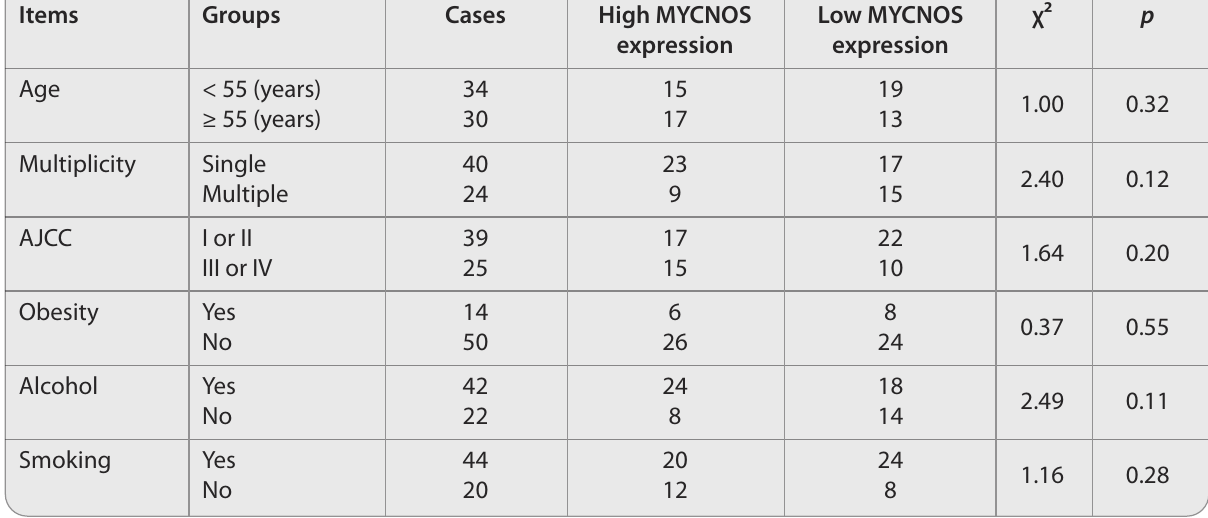
Table 1. Chi-squared test analysis of the correlations between MYCNOS expression levels and patients’ clinical data